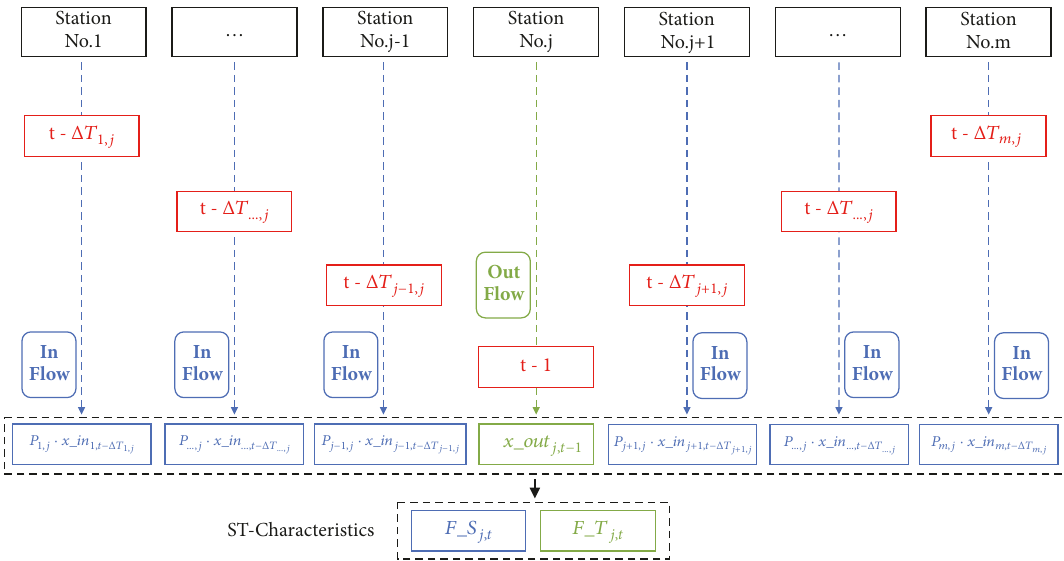
Figure 1: Design of the extraction of spatio-temporal